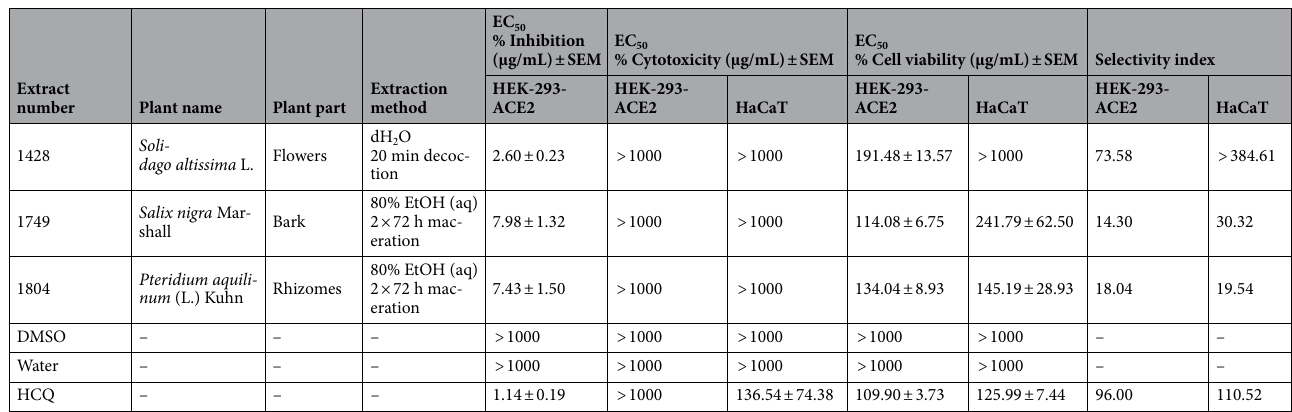
Table 2. EC 50 values were calculated by modeled dose–response curves against the wild-type SARS-CoV-2 pseudovirion model using non-linear regression. These experiments were performed in duplicate with 3 technical replicates for an n of 6. SEM standard error mean, HCQ hydroxychloroquine. Selectivity index calculation: (EC